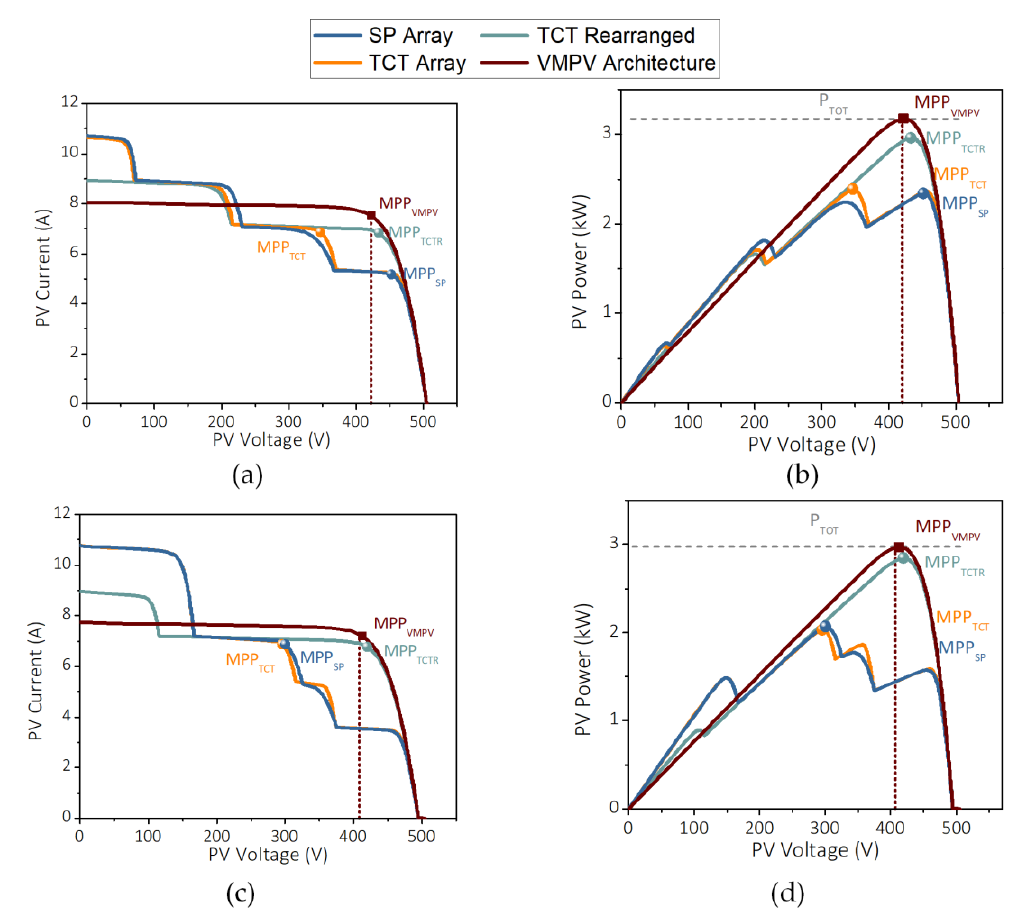
Figure 4. I-V and P-V curves of the examined PV architectures under ( a , b ) the shading pattern A and ( c , d ) the shading pattern B.